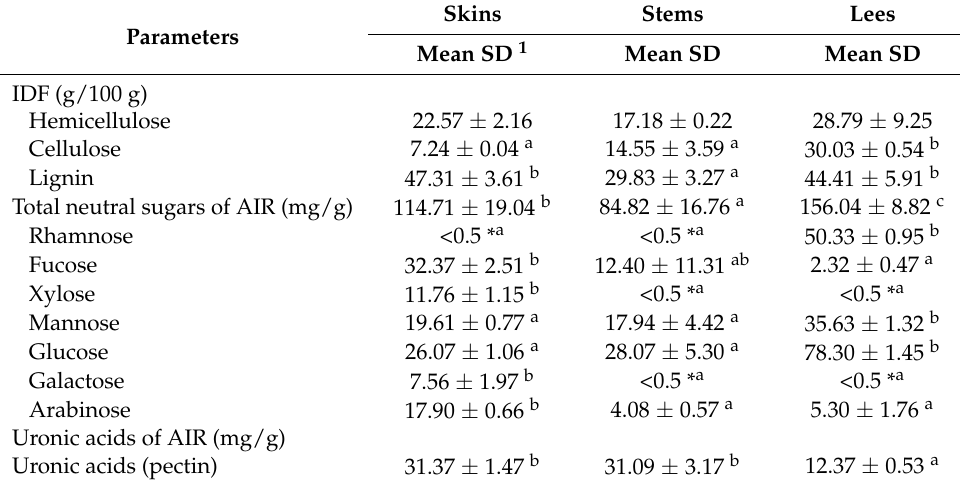
Table 2. Fibre constituents of skins, stems and